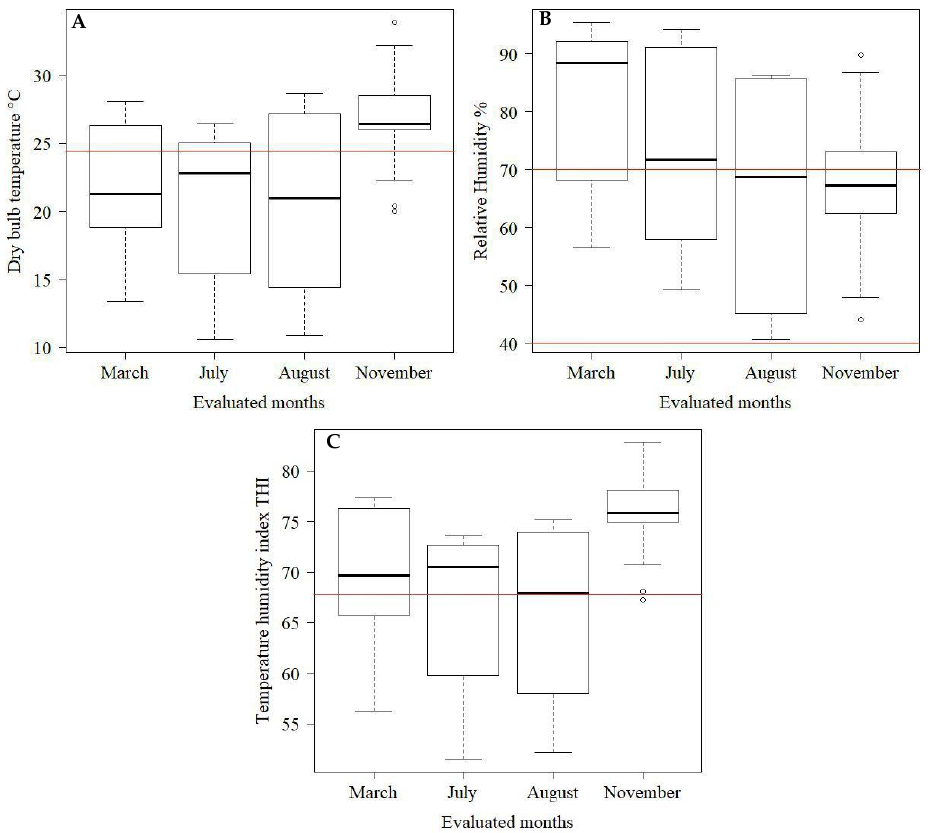
Figure 3. Box-plot of dry bulb temperature ( A ), relative humidity ( B ), and temperature humidity index ( C ) inside the barn during the experimental period. The red lines indicate the comfort values of the variables as described in the literature ([15,20,23]).